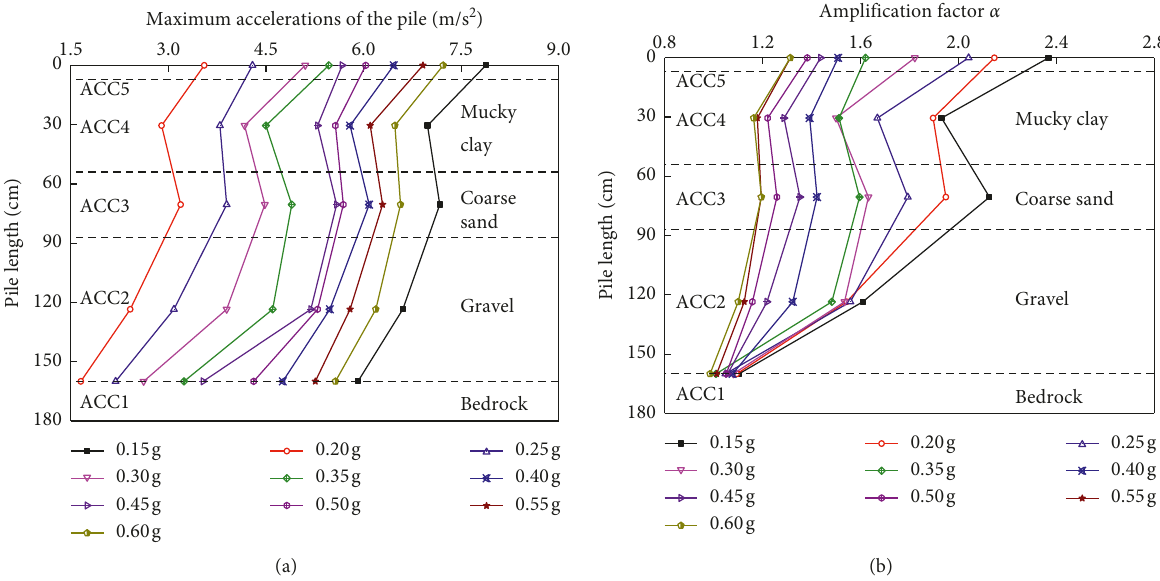
Figure 11: Pile acceleration response: (a) pile maximum acceleration of different seismic intensities and (b) amplification factor α of different seismic